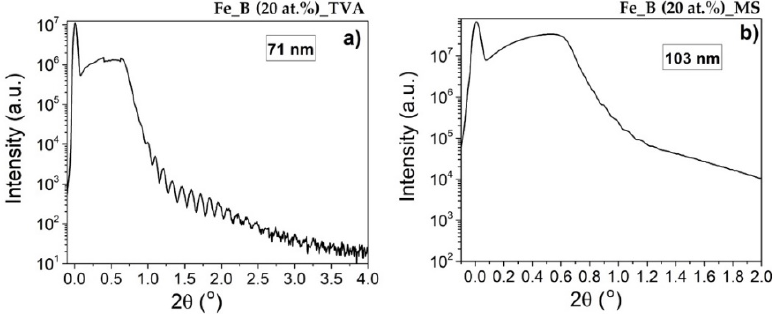
Figure 4. XRR patterns of Fe ‐ B films (20 at. % B) obtained by TVA ( a ) and MS ( b ) . EDX measurements were made on the two films with 50 at. % of B obtained by TVA and MS, respectively. The difficulty of an accurate determination of light elements (e.g.,